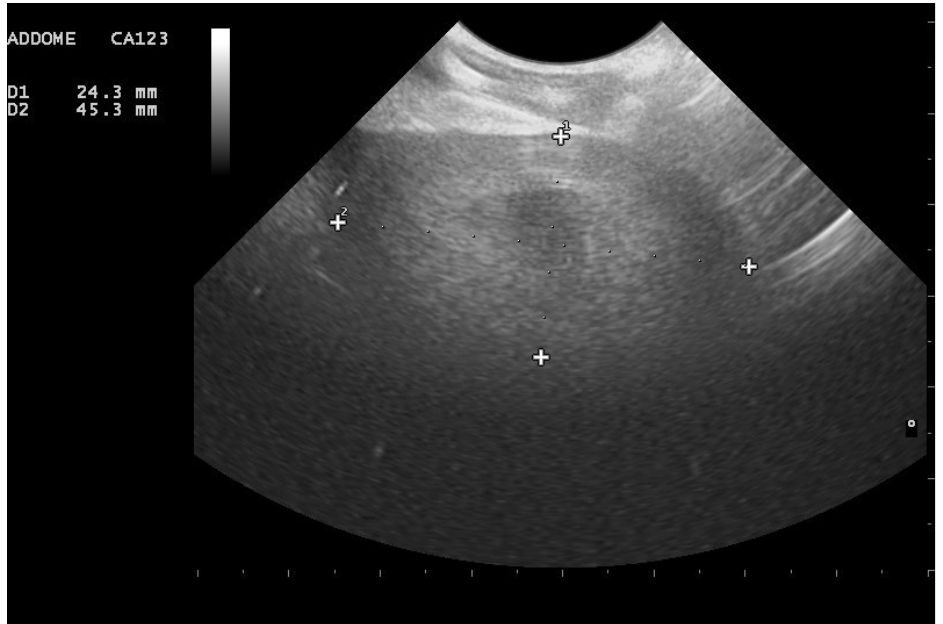
Figure 5 . Follicle in a female boa during ovulation. An oval shape with a diameter greater than 45 mm is observed in 100% of females in whom swelling was recognized at ovulation. The central part has lower echogenicity than the peripheral part.